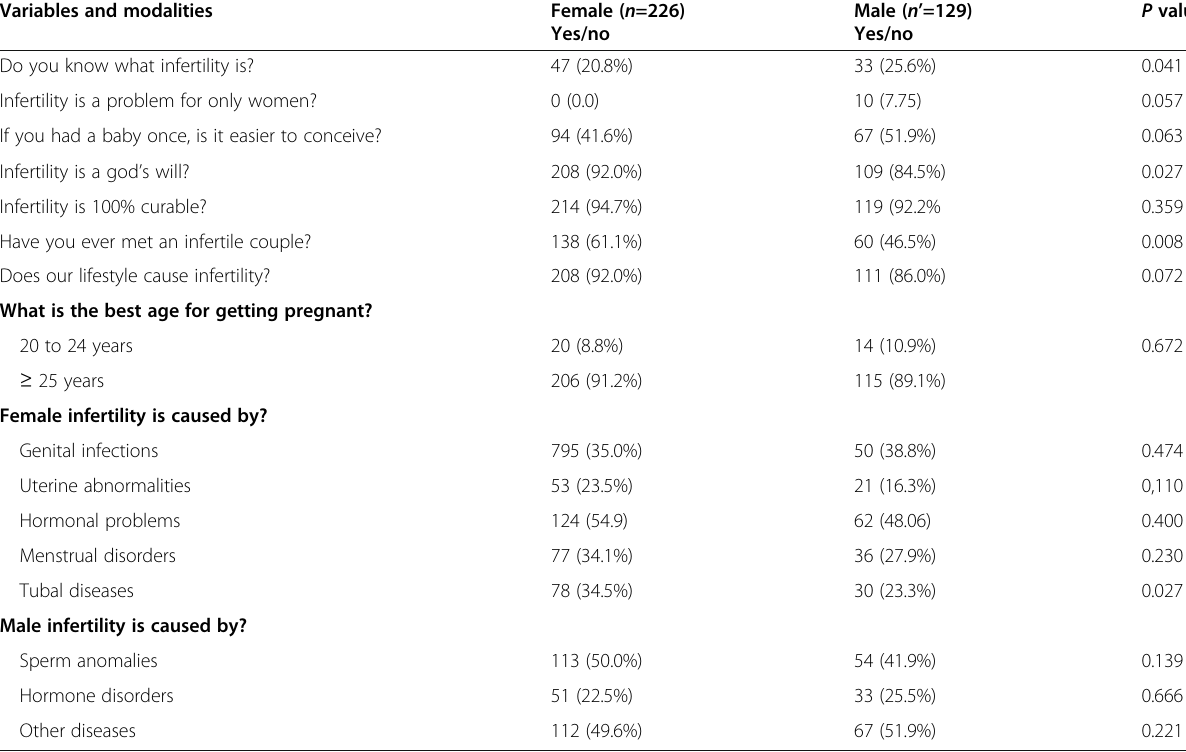
Table 2 The comparison of basic infertility knowledge, distributed by gender Variables and modalities Female ( n =226)